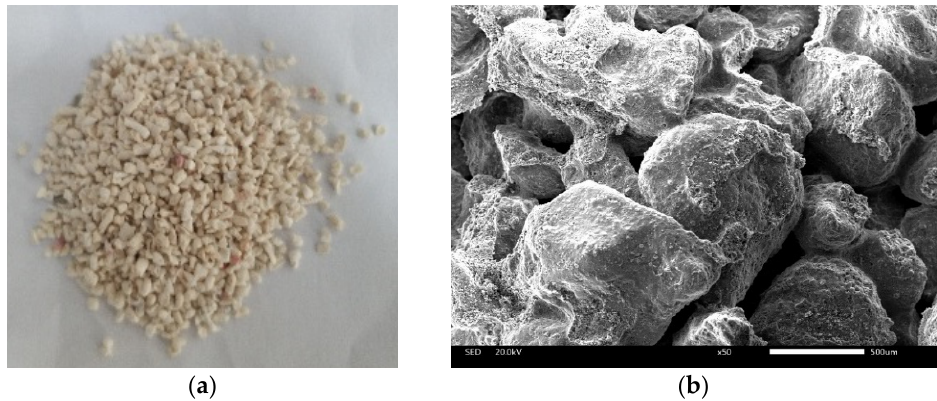
Figure 1. Particle morphology of coral sand: ( a ) picture of coral sand; ( b ) SEM image with 50 × magnification.